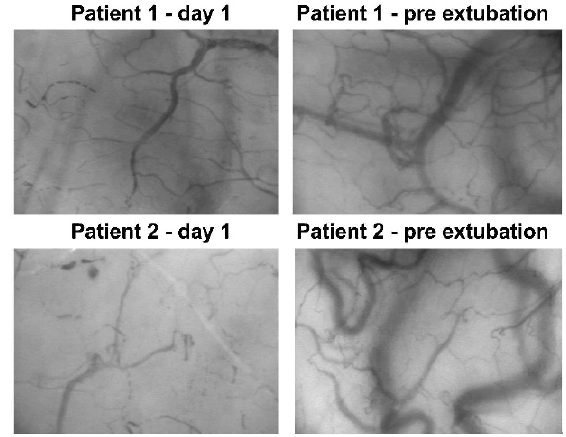
Figure 2 - Images of the sublingual microcirculation in both patients on the first day and the day prior to